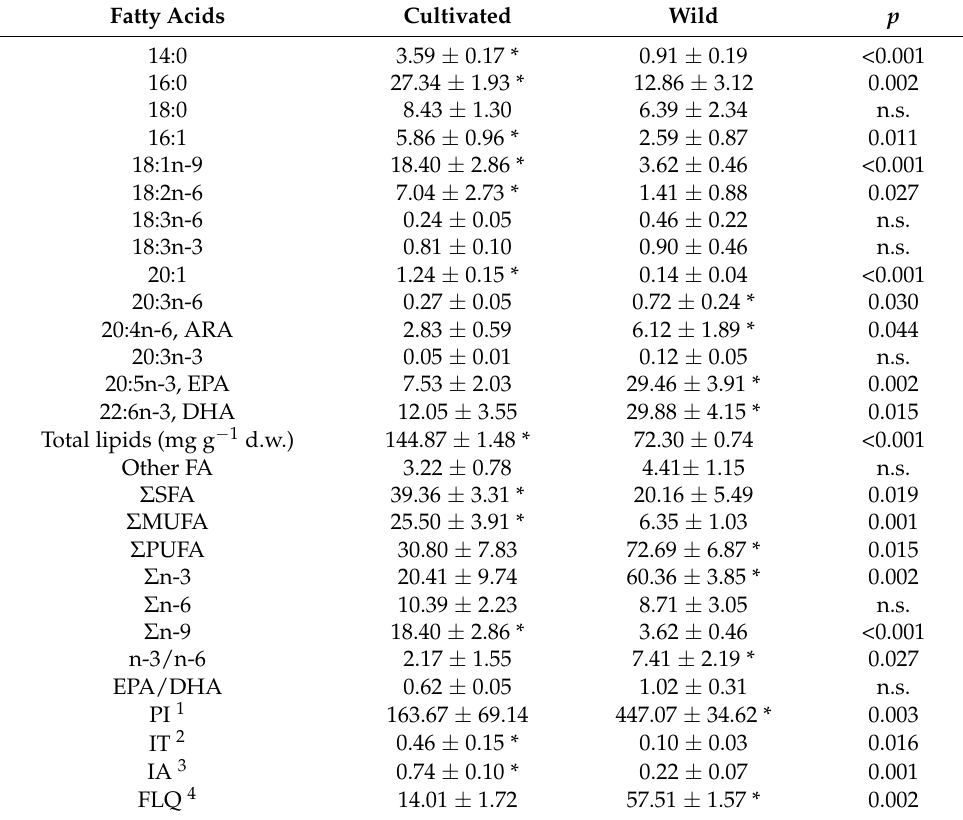
Table 4. Muscle fatty acid profile (% of total fatty acids) of wild and cultivated thick-lipped grey mullets. Fatty Acids